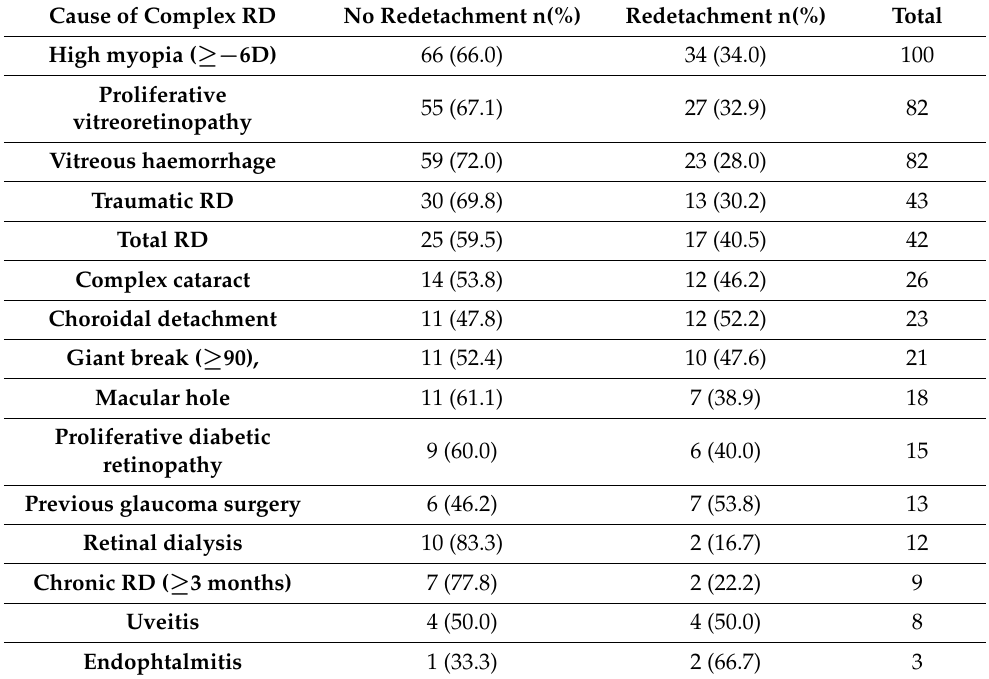
Table 4. Relationship of each type of complex retinal detachment (RD) with recurrence. The table summarises all features of the methodology identified as complicating factors. The number (n) and percentage (%) of cases of no redetachment and redetachment within each characteristic are indicated, as are the total numbers of patients with each characteristic. No Redetachment n(%)